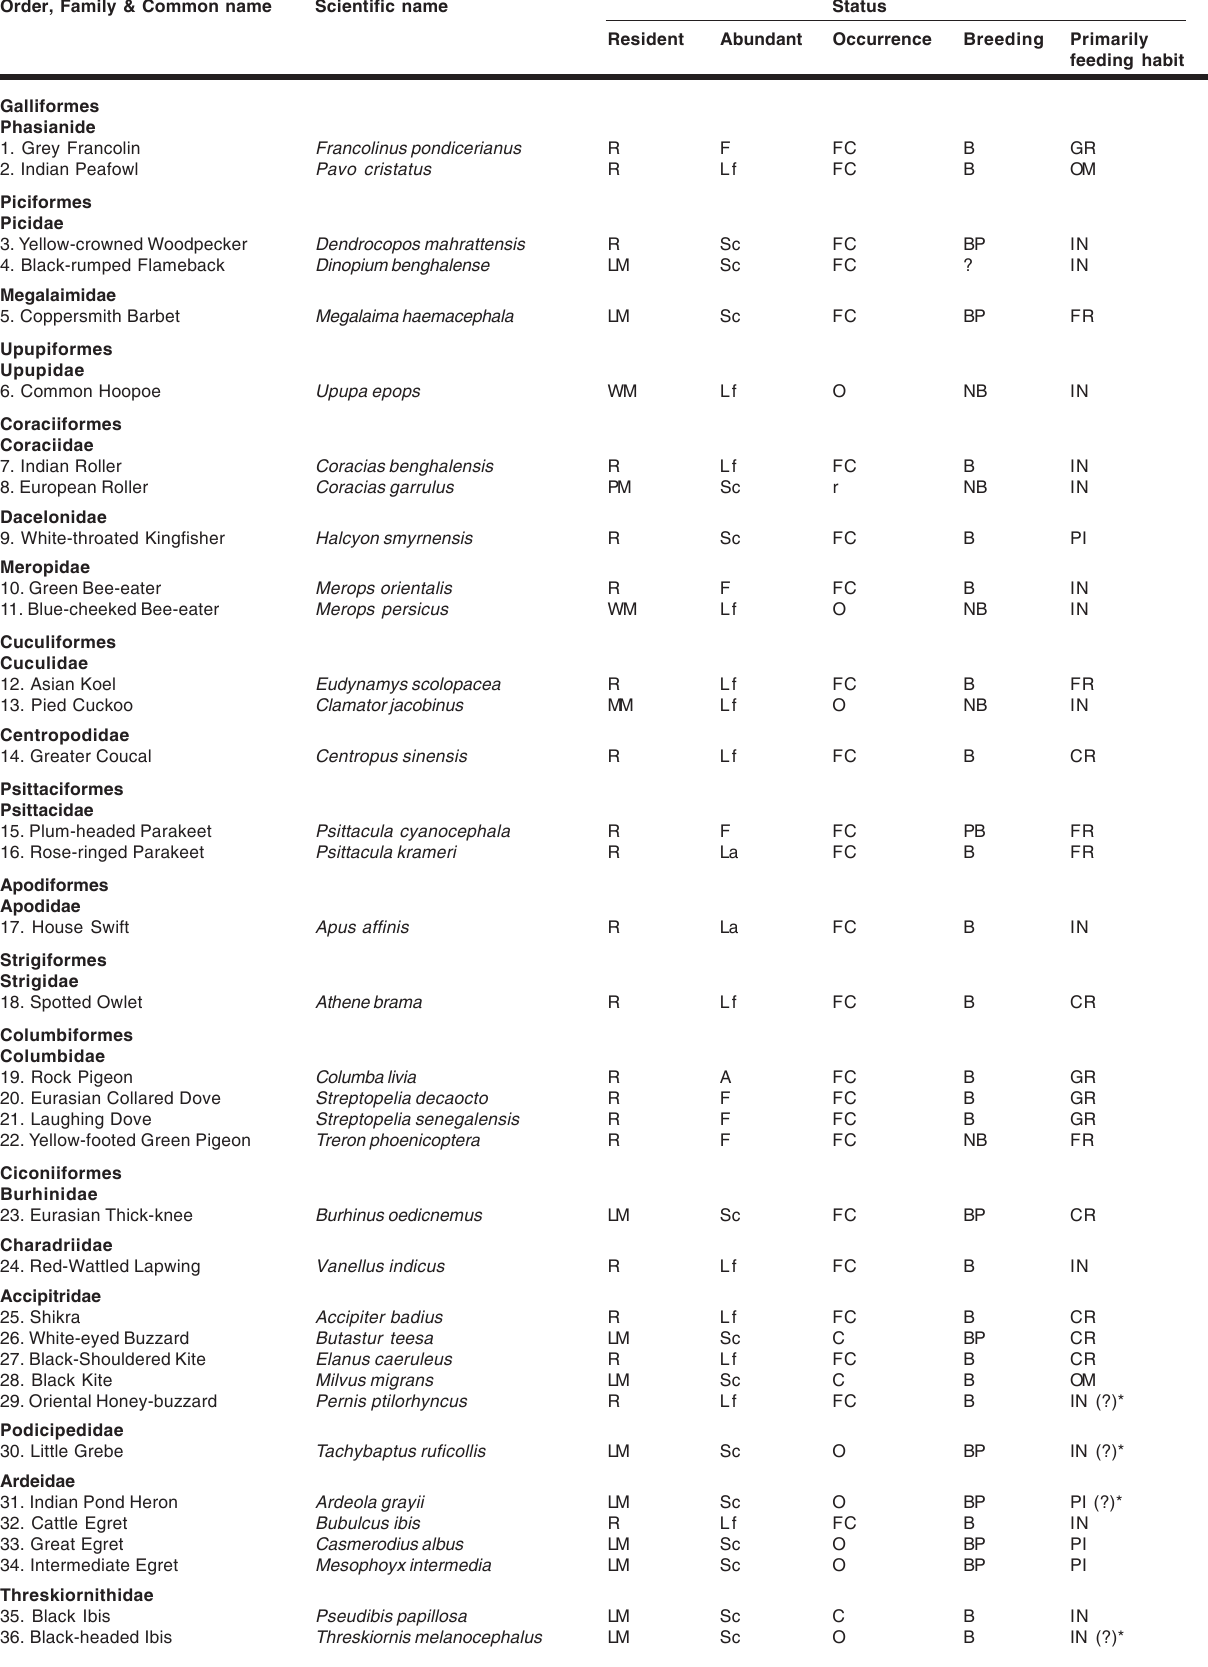
26. White-eyed Buzzard CR 27. Black-Shouldered Kite CR 28. Black Kite OM 29. Oriental